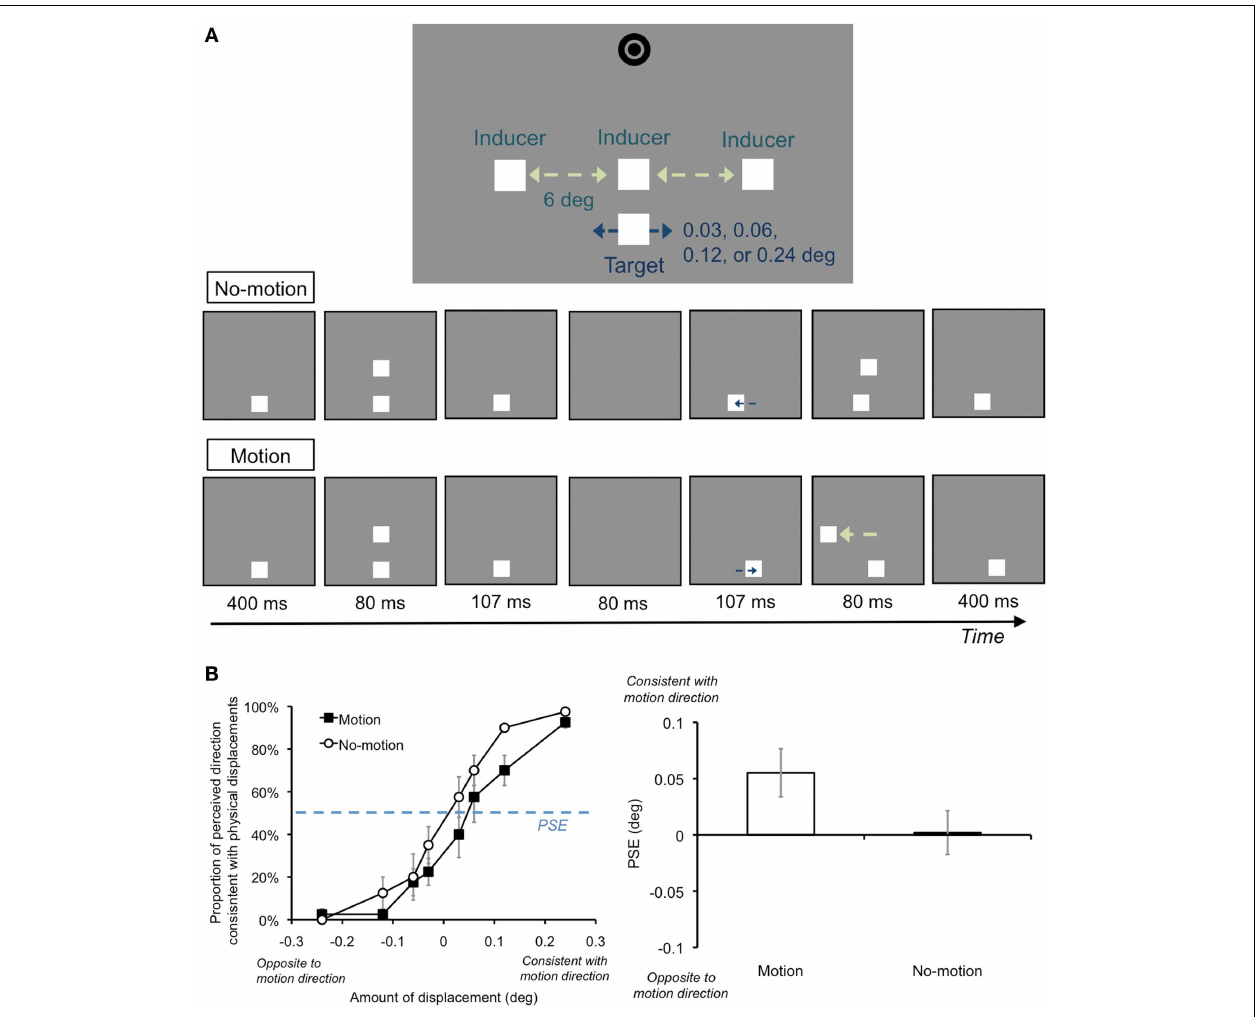
right in the Motion condition. (B) We plotted the proportion at which the perceived direction of the target was consistent with the physical displacements in each motion condition. Positive values of the target’s displacements indicate that the displacements were consistent with the AM direction in the Motion condition.We then estimated the point of subjective equality.The PSE shifted in the direction consistent with the AM so that the target displacements tended to be perceived to be opposite the AM direction in the Motion condition. Error bars denote standard errors of the mean ( N =